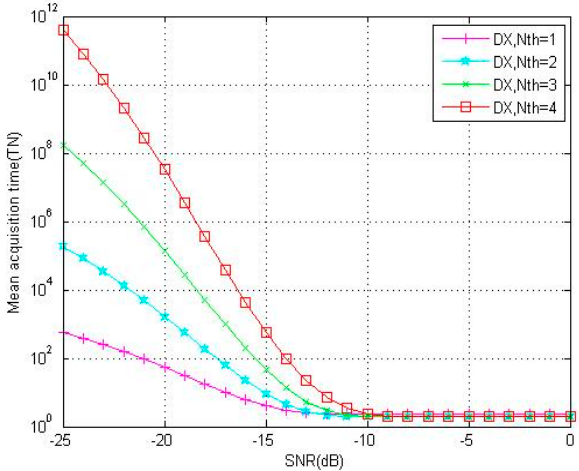
Figure 5. Theoretical (“T”, continuous line) and simulation (“S”, dotted line) results for detection probability under 1–4 verification times ( N (cid:2930)(cid:2918) ) of DC-XFAST (“DX”), DF-XFAST (“DF”) and XFAST (“XF”) with folding number equals to 5, 10 and 20 and N (cid:2930)(cid:2918) equals to 1( a ), 2( b ), 3( c ), 4( d ).